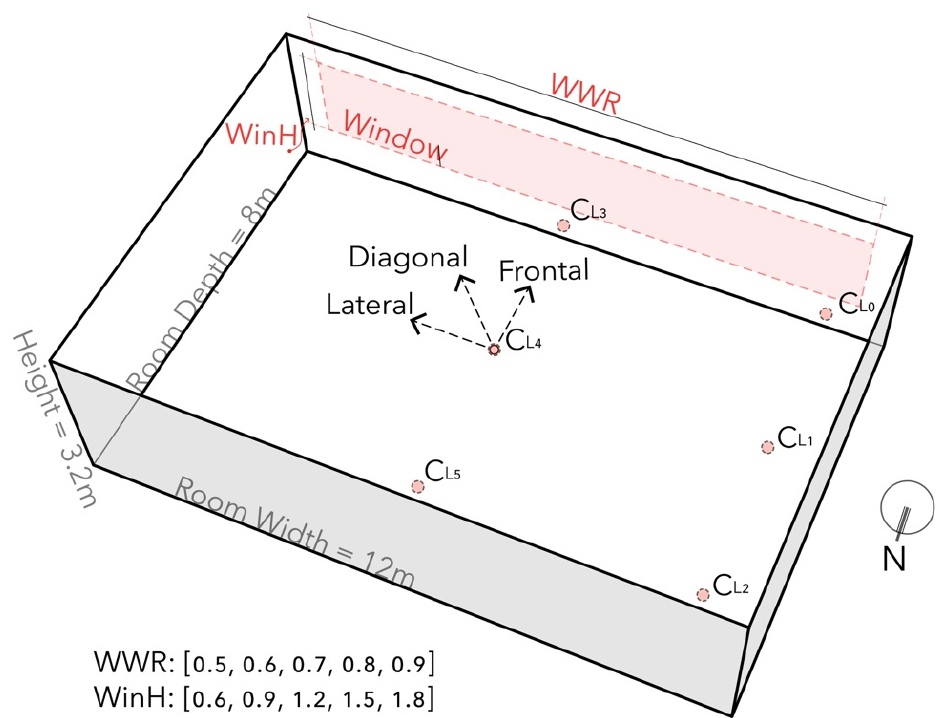
Figure 6. Parametric modelling workflow case study and viewing positions. WWH: Window Width Ratio and WinH: Window Height (meter).